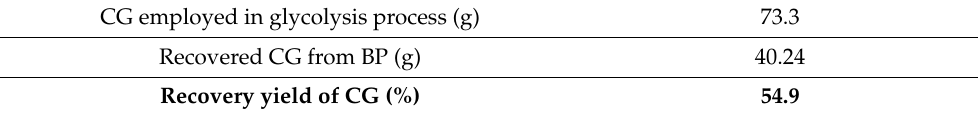
Table 9. Calculation of the recovery of crude glycerol present in the bottom